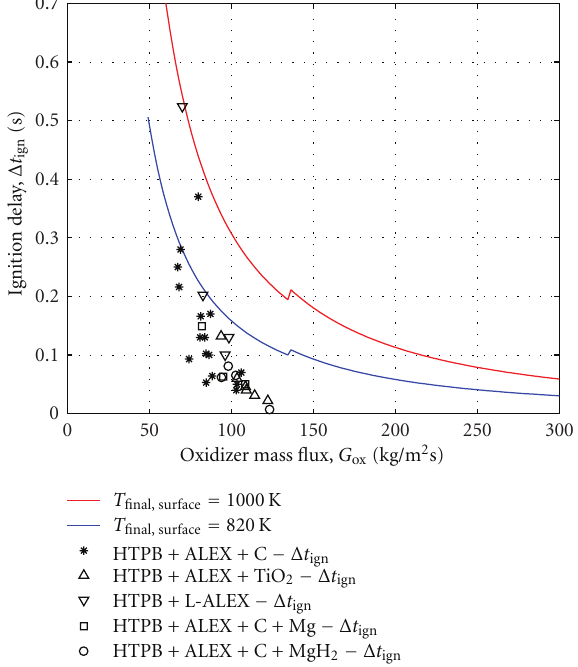
Figure 11: Ignition delay for aluminum-containing formulations. Comparison with the purely convective model by Ohlemiller and Summerfield [19], for two di ff erent final surface temperatures [25, 26].